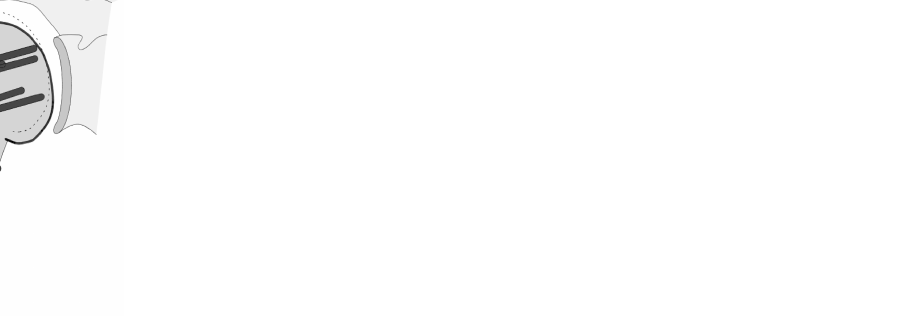
Figure 7. Complication Type 1. sample image. Mild varus displacement of the humeral head after angular stable plate osteosynthesis is shown by the transition of the dashed drawing (initially correct humeral head position) to the prominent black drawing.